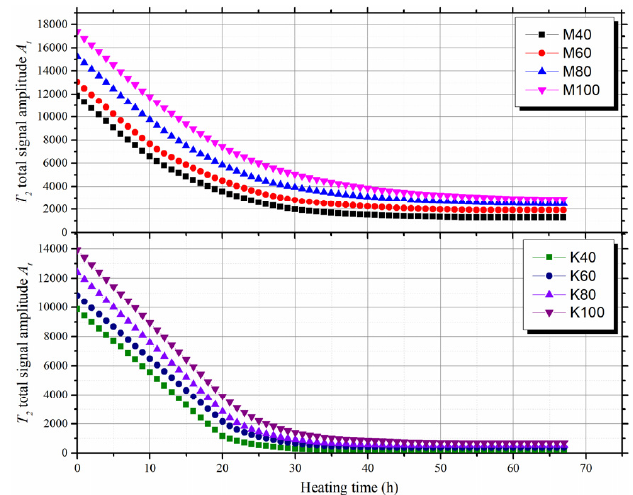
Figure 8. Variation of the T 2 total signal amplitude ( A t ) with respect to the heating time. From top to bottom, curves with di ff erent colors and symbols with di ff erent shapes indicate variation of M40, M60, M80, M100, K40, K60, K80, and K100, respectively. The scales of the Y axes of the upper and lower parts of the figure are di ff